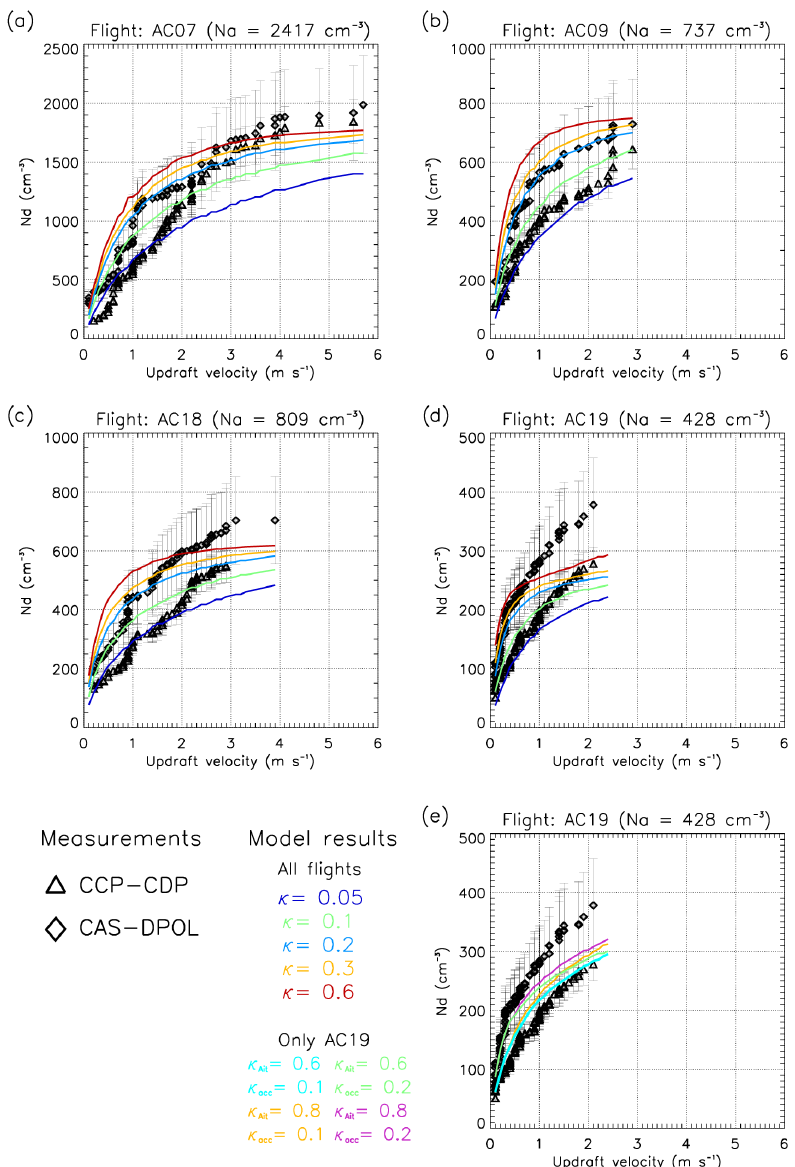
Figure 4. Cloud droplet number concentration ( N d ) as a function of updraft velocity near cloud base of convective clouds during flights: (a) AC07, (b) AC09, (c) AC18, (d) , and (e) AC19. The measured updraft velocities are based on the “probability matching method” (PMM) using the same percentiles for updraft velocity and N d,m (Sect. 3.1). The black diamonds and triangles represent N d,m near cloud base from the CAS-DPOL and CCP-CDP probes, respectively. Measurement uncertainties, indicated by error bars, are ∼ 21% and ∼ 10% for CAS-DPOL and CCP-CDP data (Braga et al., 2017a). The colored lines in panels (a–d) show N d,p assuming a single κ value for both modes (labeled on the left). Panel (e) shows N d,p based on simulations assuming different values of κ for Aitken and accumulation mode particles during flight